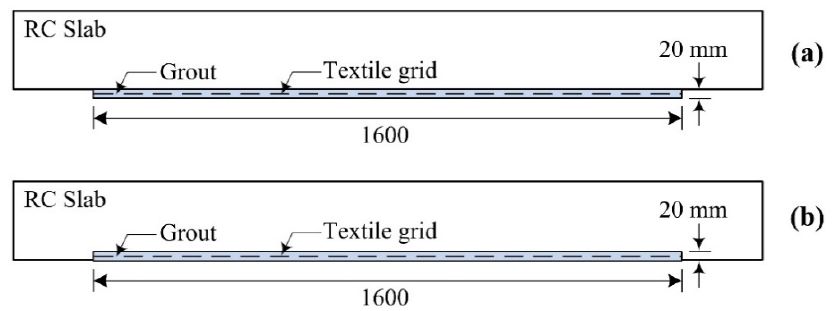
Figure 4. TRC strengthening plan for RC slabs: ( a ) SG-1 series specimens; and ( b ) SG-2 series specimens. Figure 5 depicts the TRC strengthening process for the RC slabs during the fabrication.